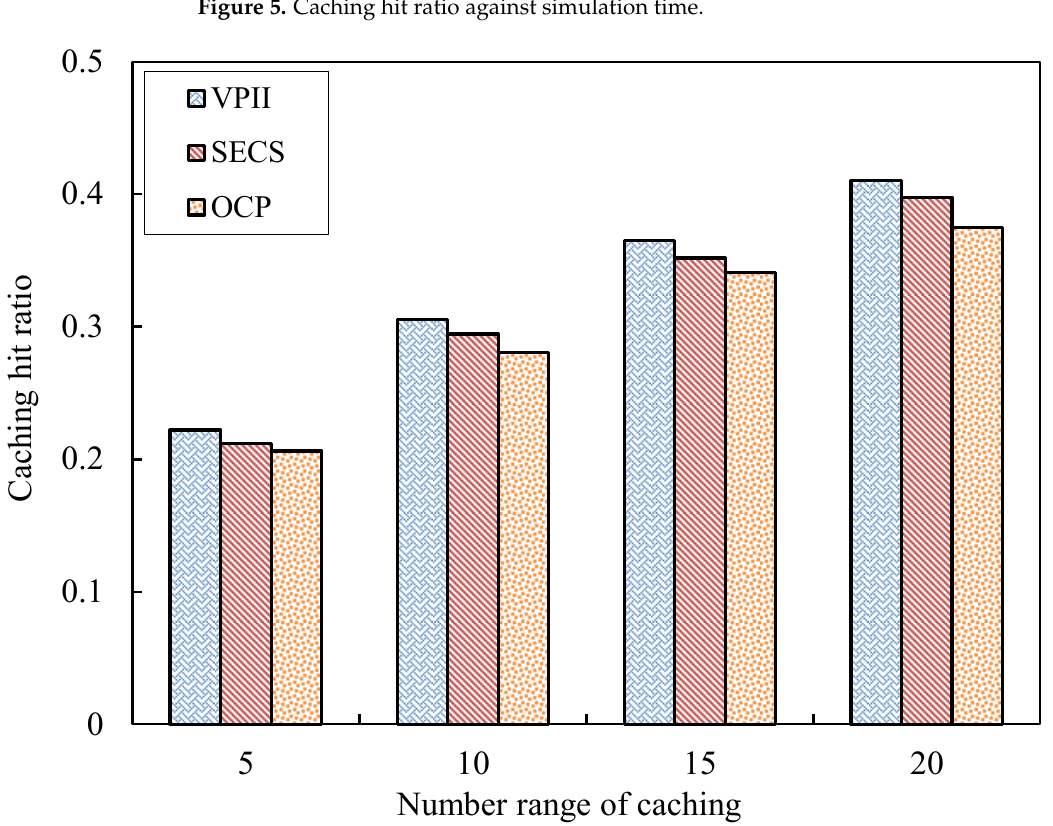
Figure 6. Caching hit ratio against number of cached